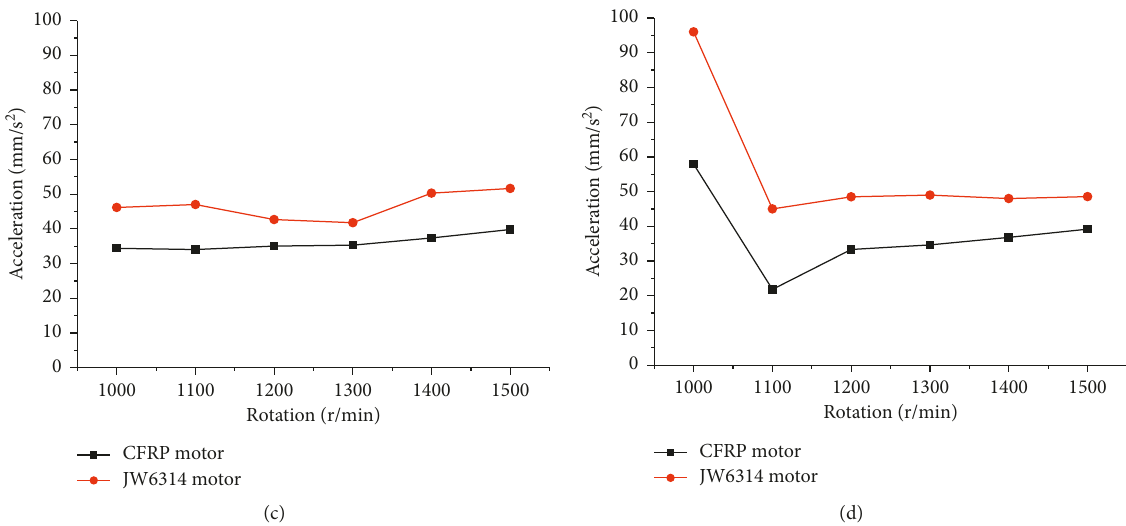
Figure 14: Comparison of acceleration amplitude of two kinds of motors. (a) Sensor 1 on the base. (b) Sensor 2 on the cylinder. (c) Sensor 3 on the cylinder. (d) Sensor 4 on the